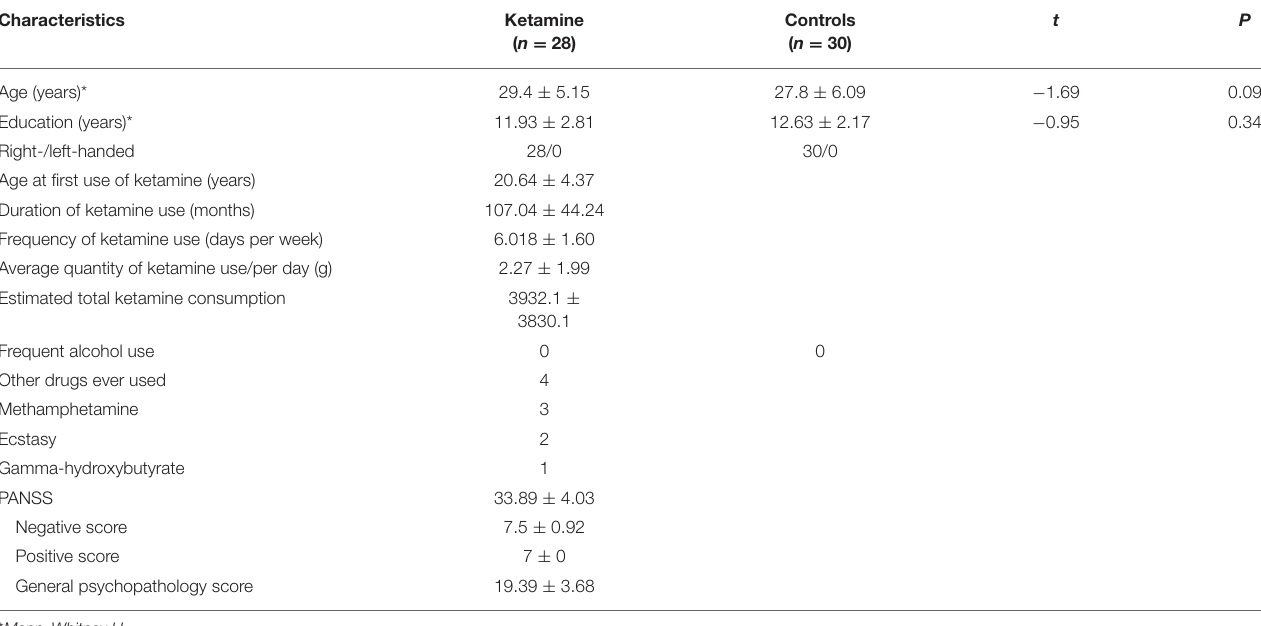
TABLE 1 | Demographic characteristics of chronic ketamine users and healthy controls (HCs).